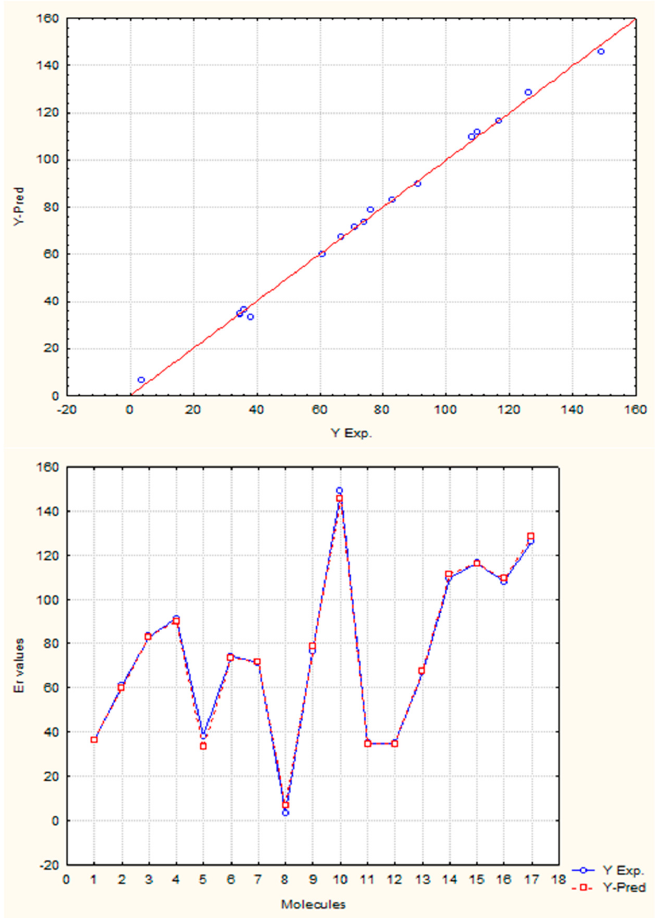
Figure 11. Regression and prediction graphs for the Equation (27).